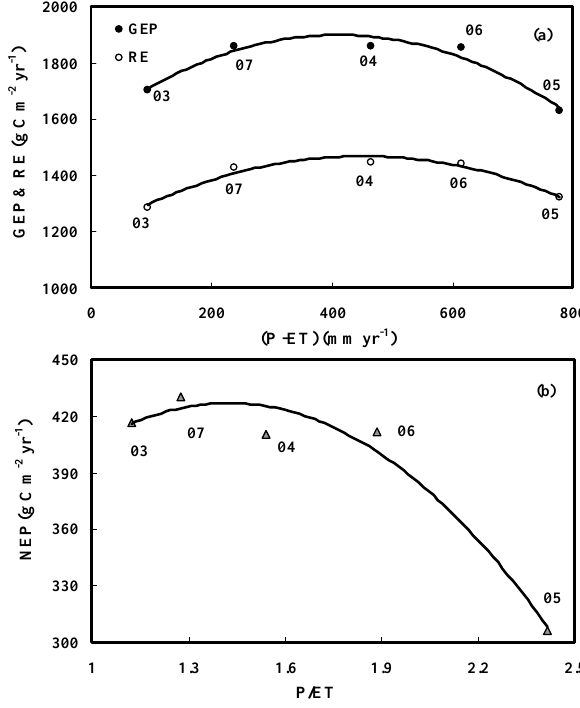
RE= 0.78GEP R 2 = 0.78, p<0.01